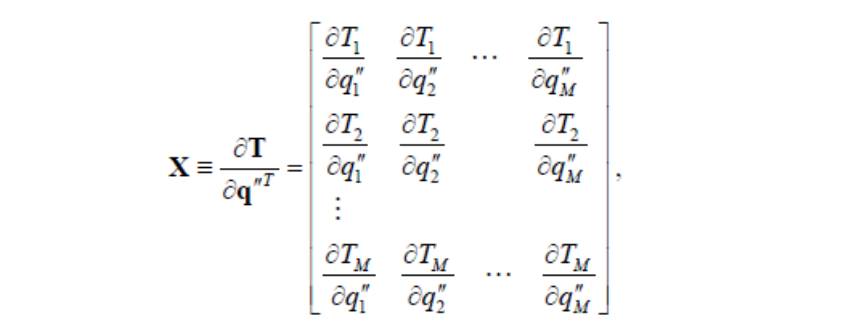
C) Table 7: missing symbol: D) Dear Editor, I suggest the folowing changes in the ACKNOWLEDGMENTS and FUNDING